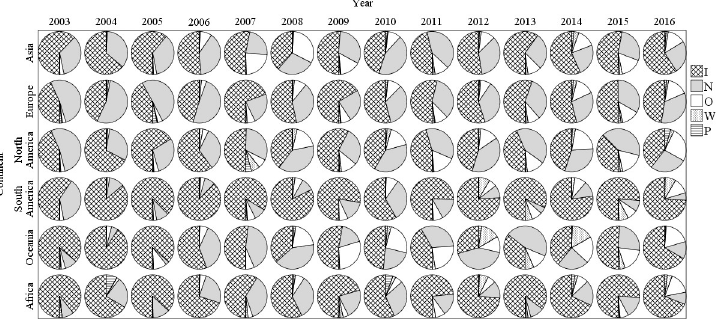
Fig 2. Pie chart of wood packaging pest taxa intercepted from different continents from 2003 to 2016. I = Insects, N = Nematodes, W = Weeds, P = Pathogens, O = Others (e.g. mites, spiders, mollusks).